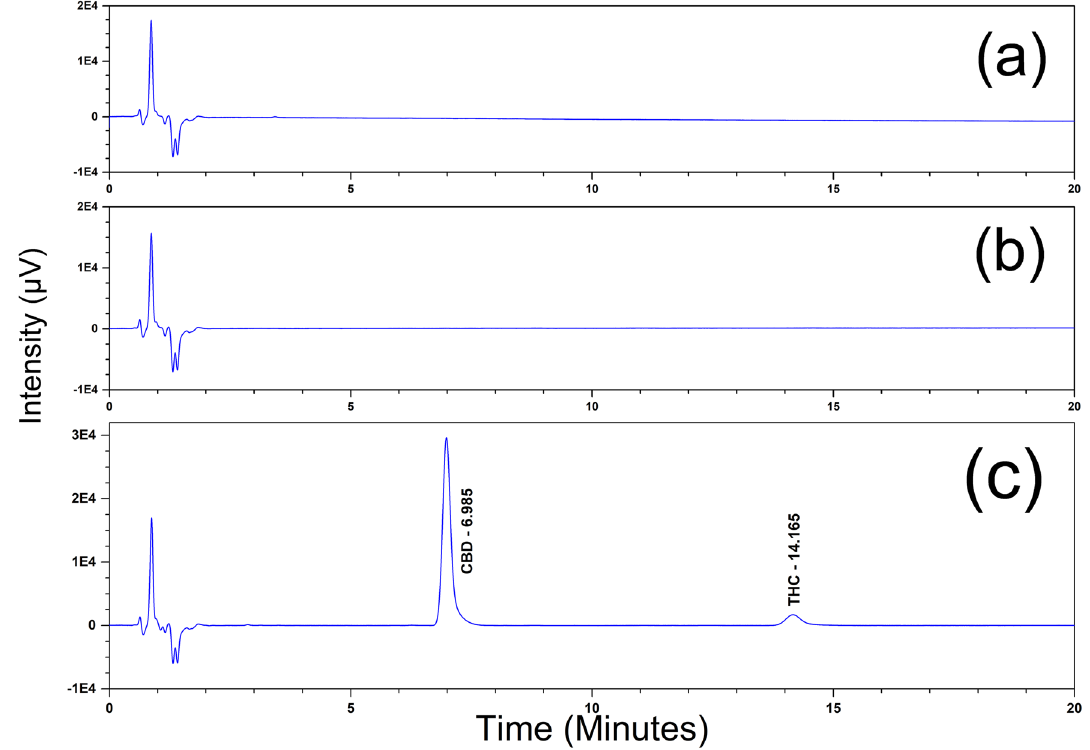
Figure 4. Specificity chromatograms of ( a ) diluent blank ( b ) un-spiked placebo and ( c ) spiked placebo samples of CBD and THC